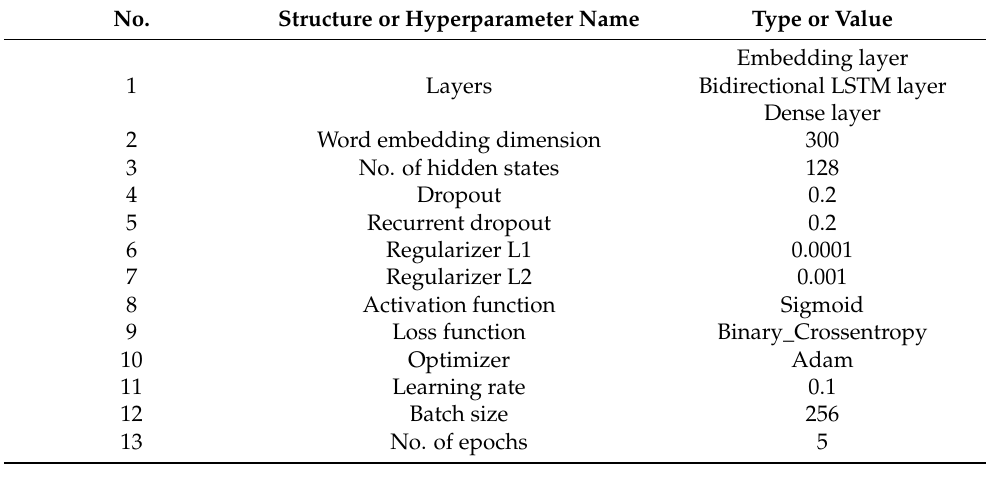
Table 4. The architecture of the proposed fake news detection model.